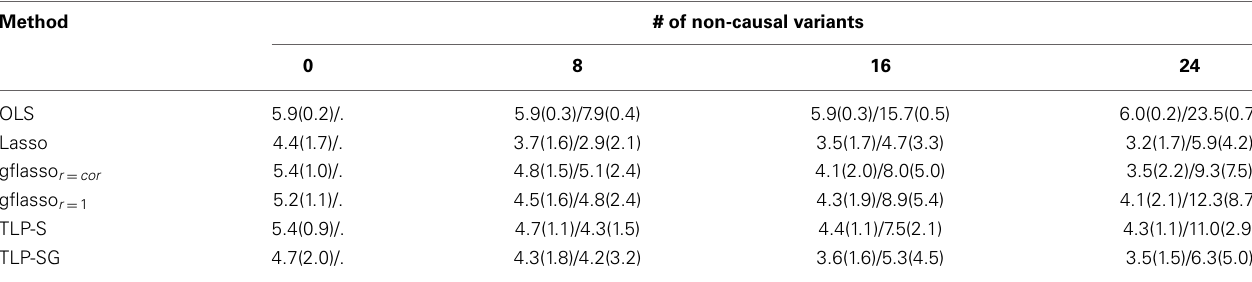
Table 3 | Mean numbers of TP(sd)/FP(sd) of the methods in Case 2 with both RVs and CVs.